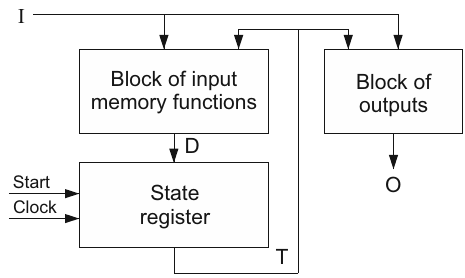
Figure 2. Structural diagram of P Mealy